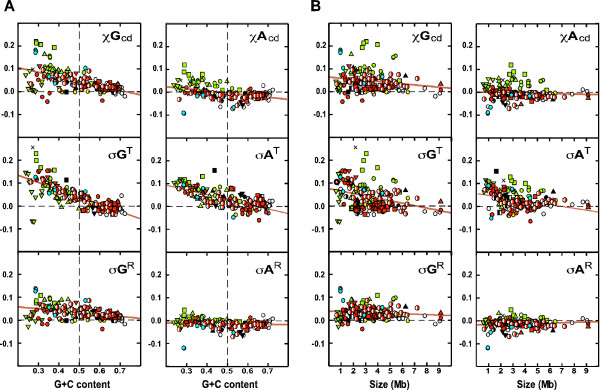
Correlation between the G+C content and the size of the chromosomes and the effects of RAP and TAP. σGcdR
 MathType@MTEF@5@5@+=feaafiart1ev1aaatCvAUfKttLearuWrP9MDH5MBPbIqV92AaeXatLxBI9gBaebbnrfifHhDYfgasaacH8akY=wiFfYdH8Gipec8Eeeu0xXdbba9frFj0=OqFfea0dXdd9vqai=hGuQ8kuc9pgc9s8qqaq=dirpe0xb9q8qiLsFr0=vr0=vr0dc8meaabaqaciaacaGaaeqabaqabeGadaaakeaaiiGacqWFdpWCcqWGhbWrdaqhaaWcbaGaem4yamMaemizaqgabaGaemOuaifaaaaa@3387@, σGcdT
 MathType@MTEF@5@5@+=feaafiart1ev1aaatCvAUfKttLearuWrP9MDH5MBPbIqV92AaeXatLxBI9gBaebbnrfifHhDYfgasaacH8akY=wiFfYdH8Gipec8Eeeu0xXdbba9frFj0=OqFfea0dXdd9vqai=hGuQ8kuc9pgc9s8qqaq=dirpe0xb9q8qiLsFr0=vr0=vr0dc8meaabaqaciaacaGaaeqabaqabeGadaaakeaaiiGacqWFdpWCcqWGhbWrdaqhaaWcbaGaem4yamMaemizaqgabaGaemivaqfaaaaa@338B@, χGcd, σAcdT
 MathType@MTEF@5@5@+=feaafiart1ev1aaatCvAUfKttLearuWrP9MDH5MBPbIqV92AaeXatLxBI9gBaebbnrfifHhDYfgasaacH8akY=wiFfYdH8Gipec8Eeeu0xXdbba9frFj0=OqFfea0dXdd9vqai=hGuQ8kuc9pgc9s8qqaq=dirpe0xb9q8qiLsFr0=vr0=vr0dc8meaabaqaciaacaGaaeqabaqabeGadaaakeaaiiGacqWFdpWCcqWGbbqqdaqhaaWcbaGaem4yamMaemizaqgabaGaemivaqfaaaaa@337F@, σAcdR
 MathType@MTEF@5@5@+=feaafiart1ev1aaatCvAUfKttLearuWrP9MDH5MBPbIqV92AaeXatLxBI9gBaebbnrfifHhDYfgasaacH8akY=wiFfYdH8Gipec8Eeeu0xXdbba9frFj0=OqFfea0dXdd9vqai=hGuQ8kuc9pgc9s8qqaq=dirpe0xb9q8qiLsFr0=vr0=vr0dc8meaabaqaciaacaGaaeqabaqabeGadaaakeaaiiGacqWFdpWCcqWGbbqqdaqhaaWcbaGaem4yamMaemizaqgabaGaemOuaifaaaaa@337B@, and χAcd are plotted against the G+C content (A), and the size (B) of the chromosomes. The linear regression lines are in red. The symbols for the bacterial chromosomes are as in Figure 1.